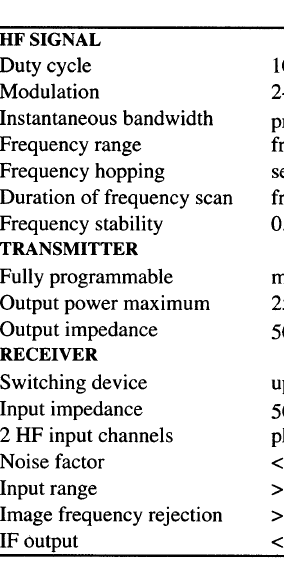
Fig. 1. Performance